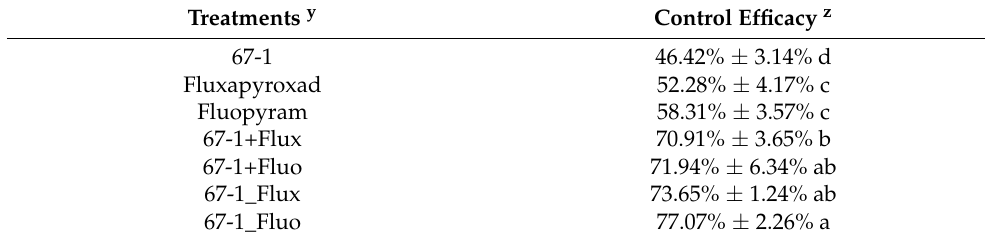
Table 3. Control efficacy on tomato gray mold in greenhouse experiment.